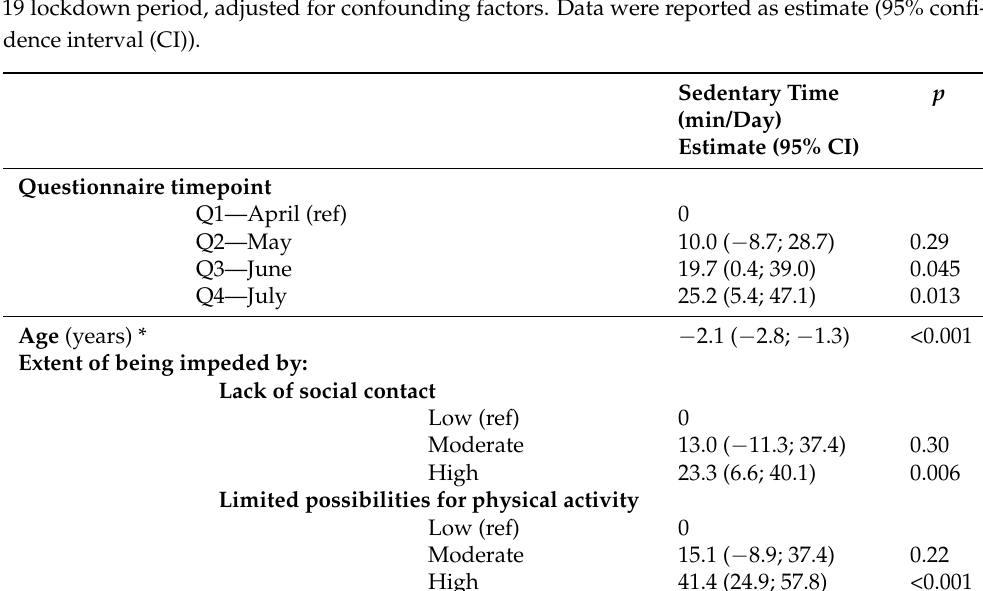
Table 2. Final multivariate mixed model for changes in sedentary time during the first-wave COVID- 19 lockdown period, adjusted for confounding factors. Data were reported as estimate (95% confi- dence interval (CI)).